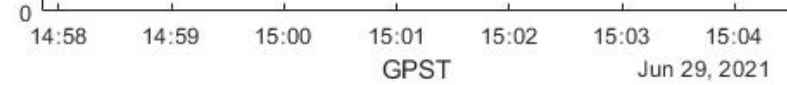
Figure 11. Number of exclusions for each type of measurement (round 5).